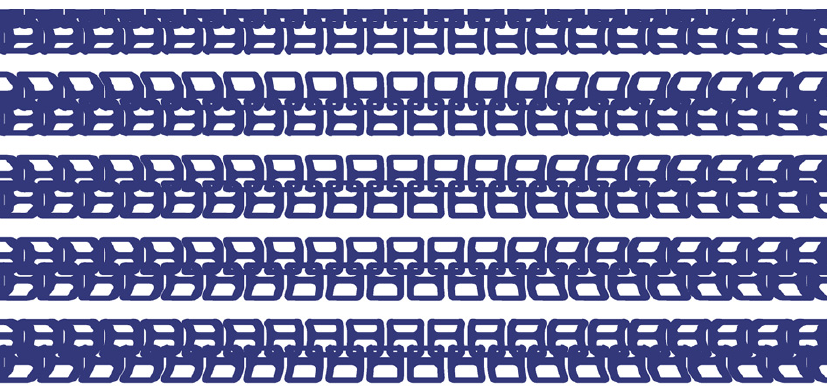
Figure 6. Construction of the chainmail.